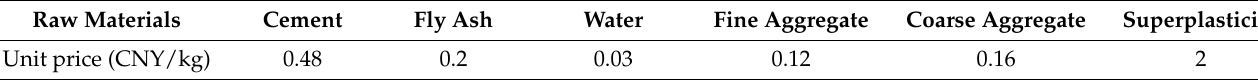
Table 9. Unit price list of materials.